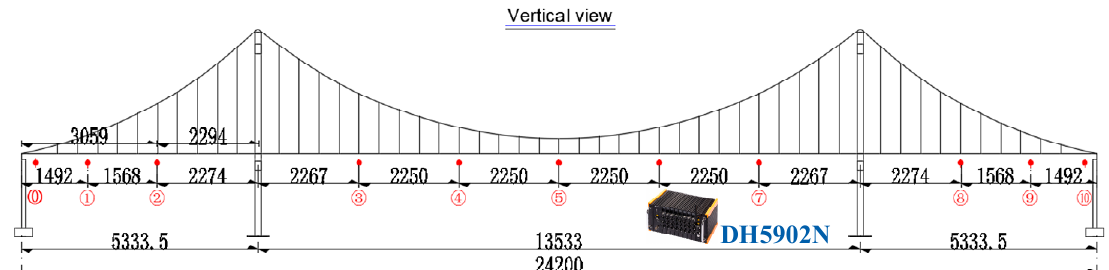
Figure 9. The arrangement of dial gauges.